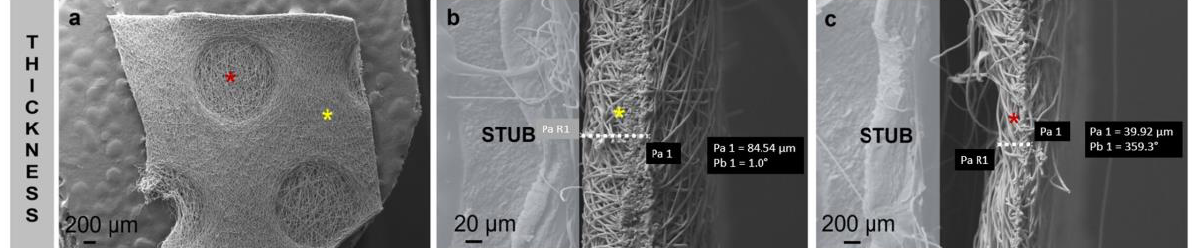
Figure 5. Representative SEM images of Biofiber texture electrospun dressing topography ( a ) at dif- ferent magnification 50 X-700 X. Images of textured (red star), and no-textured area (yellow star) thickness measurement ( b ) and round pattern textured portions ( c ).